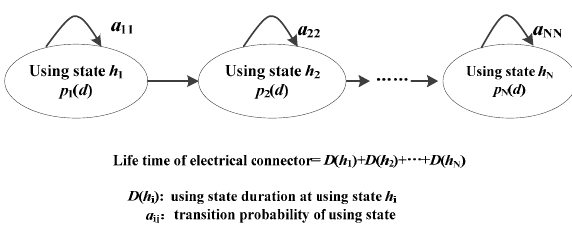
Figure 7. Residual life prediction model based on HSMM.